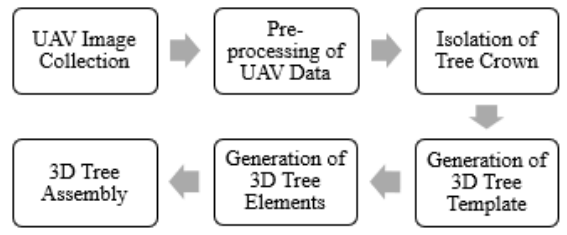
Figure 2. General methodology of this